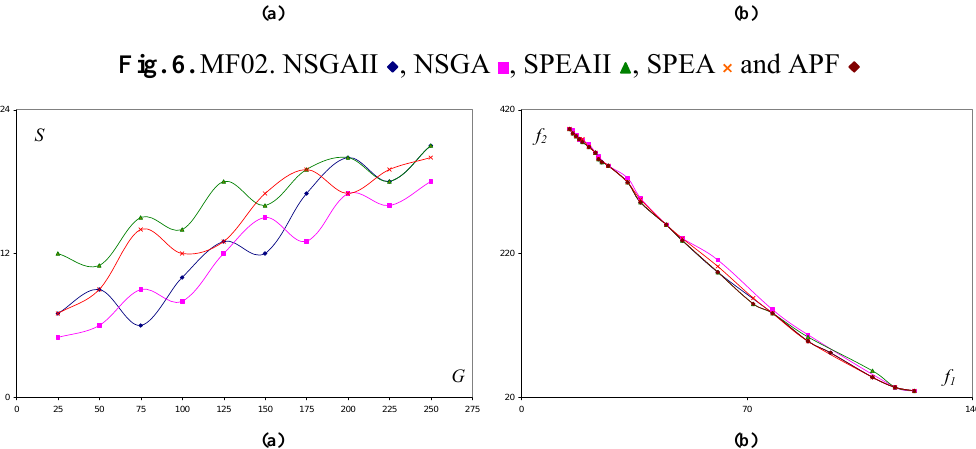
Fig. 6. MF02. NSGAII , NSGA , SPEAII , SPEA and APF